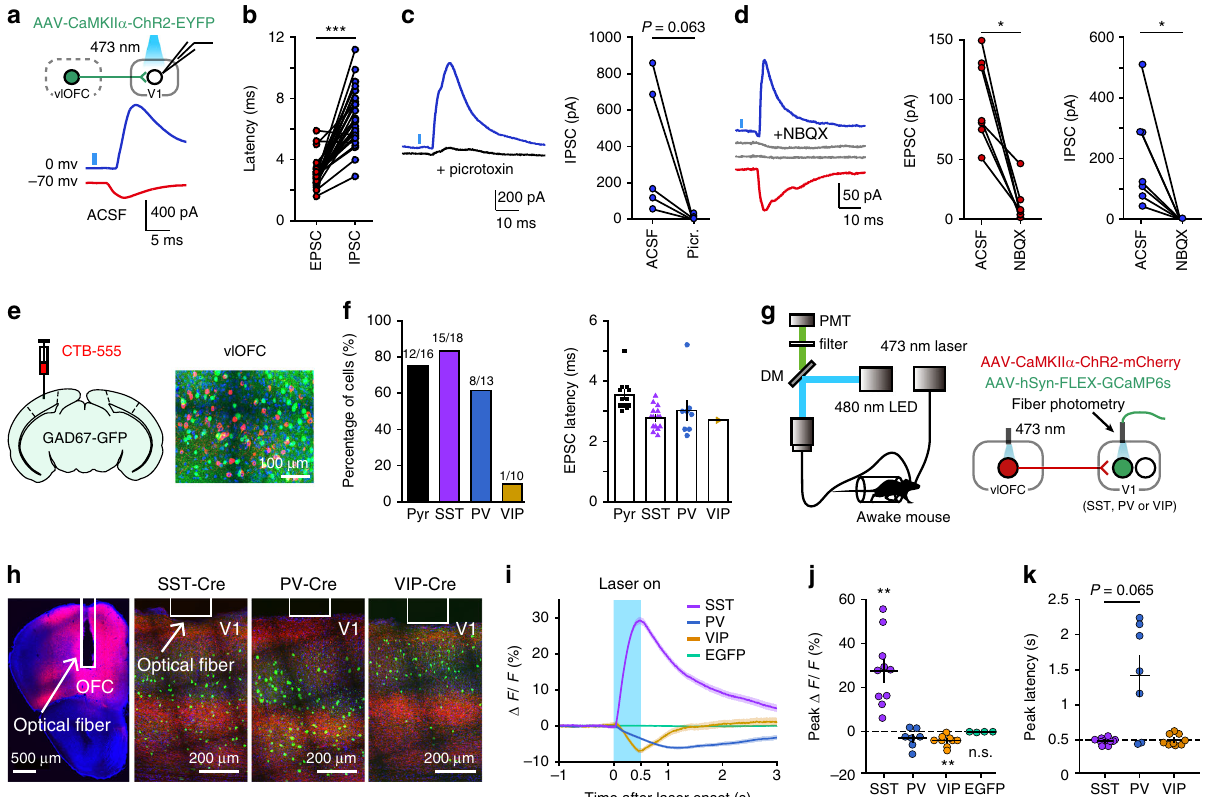
Fig. 2 Activating OFC axons activates V1 inhibitory interneurons. a Photostimulation of OFC projection to V1 evoked both EPSCs (red) and IPSCs (blue) in a V1 neuron. b The EPSC latencies vs IPSC latencies (*** P = 2.34 × 10 − 6 , n = 30, in which n = 7, 12, 1, 1, and 9 for pyramidal, SST, PV, VIP, and unidenti fi ed neurons, respectively). c Left, GABA A receptor antagonist (picrotoxin, 30 μ M) application blocked IPSCs in a V1 neuron. Black, IPSCs after picrotoxin application. Right, IPSCs amplitudes before and after picrotoxin application ( P = 0.063, n = 5). d Left, AMPA receptor antagonist (NBQX, 10 μ M) application blocked both EPSCs and IPSCs in a V1 neuron. Gray, EPSCs and IPSCs after NBQX application. Middle and right, EPSCs (IPSCs) amplitudes before and after NBQX application ( P = 0.016 and n = 7 neurons for both EPSCs and IPSCs). e CTB was injected in V1 of a GAD67-GFP mouse. Retrograde labeling of OFC neurons did not overlap with GFP-positive OFC neurons. f Left, fraction of pyramidal (Pyr) and inhibitory interneurons showing laser- evoked EPSCs. Right, EPSC latency for each type of neuron. g Schematic of the strategy to record activities of speci fi c interneuron type in V1 evoked by OFC activation. h Fluorescence image of OFC in which AAV-CaMKII α -ChR2-mCherry was injected, and those of V1 injected with AAV-hSyn-FLEX-GCaMP6s from a SST-Cre, PV-Cre, and VIP-Cre mouse, respectively. White rectangles, placement of the optic fi ber. The results were replicated >6 times. i Representative Δ F / F signals from a SST-Cre, PV-Cre, VIP-Cre mouse, and a C57BL/6 mouse (AAV-hSyn-EGFP injected in V1), respectively. Blue, OFC stimulation. j Amplitude of peak Δ F / F . SST: ** P = 0.002, n = 10 mice; PV: P = 0.078, n = 7 mice; VIP: ** P = 0.004, n = 9 mice; EGFP: P = 0.13, n = 4 mice. k Latency of peak Δ F / F . SST vs PV: P = 0.065 (Wilcoxon two-sided rank sum test). Wilcoxon two-sided signed rank test for b , c , d , j . For b − d , f , and i – k